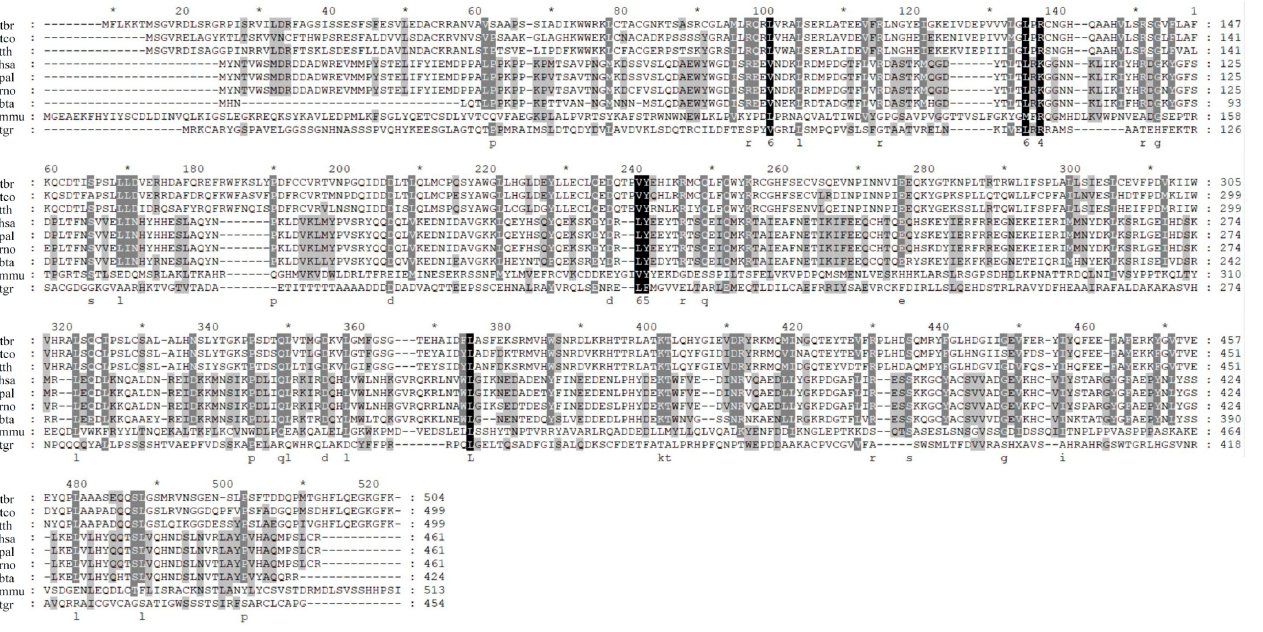
Figure 5. Multiple sequence alignment of Pi3K proteins among different species. The asterisk indicated the middle of two sites. The shadow indicated the similarity level in the site. Abbreviation for the species: bta, Bos taurus ; hsa, Homo sapiens ; mmu, Mus musculus ; pal, Pteropus alecto ; rno, Rattus norvegicus ; tbr, Trypanosoma brucei ; tco, Trypanosoma conorhini ; tgr, Trypanosoma grayi; tth, Trypanosoma theileri .